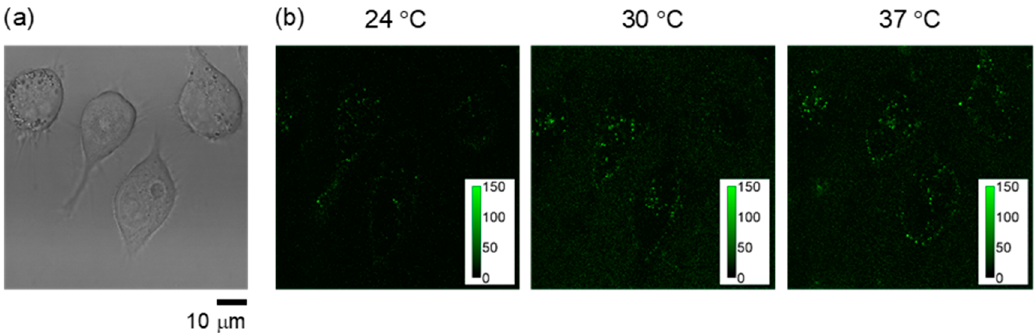
Figure 7. Fluorescence response of NANOGEL- 6 in live HeLa cells. ( a ) Transmitted light image at 37 °C; ( b ) confocal fluorescence image (excitation: 458 nm; emission: 500–600 nm) at 24 °C (left), 30 °C (middle) and 37 °C (right). Color bars in the fluorescence images indicate the fluorescence intensity (arbitrary unit).